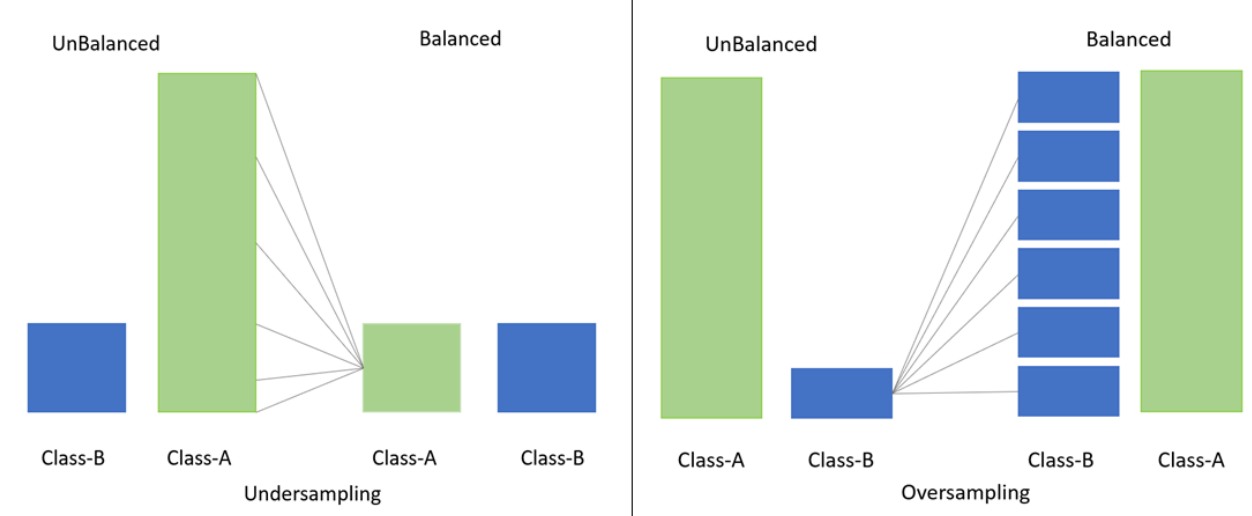
Figure 3. Schematic diagram of over-sampling and under-sampling.